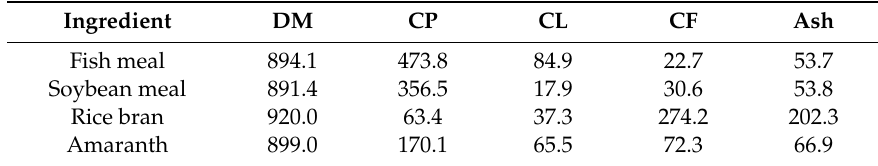
Table 1. Proximate composition (g / Kg DM) of the ingredients used in the experimental diets to tilapia cultured in ponds.